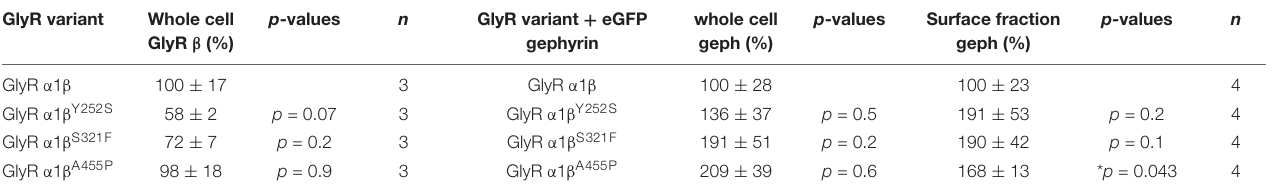
TABLE 1 | Expression of GlyR β variants in the presence and absence of gephyrin in transfected cells. GlyR variant Whole cell p -values n GlyR variant + eGFP GlyR β (%) gephyrin